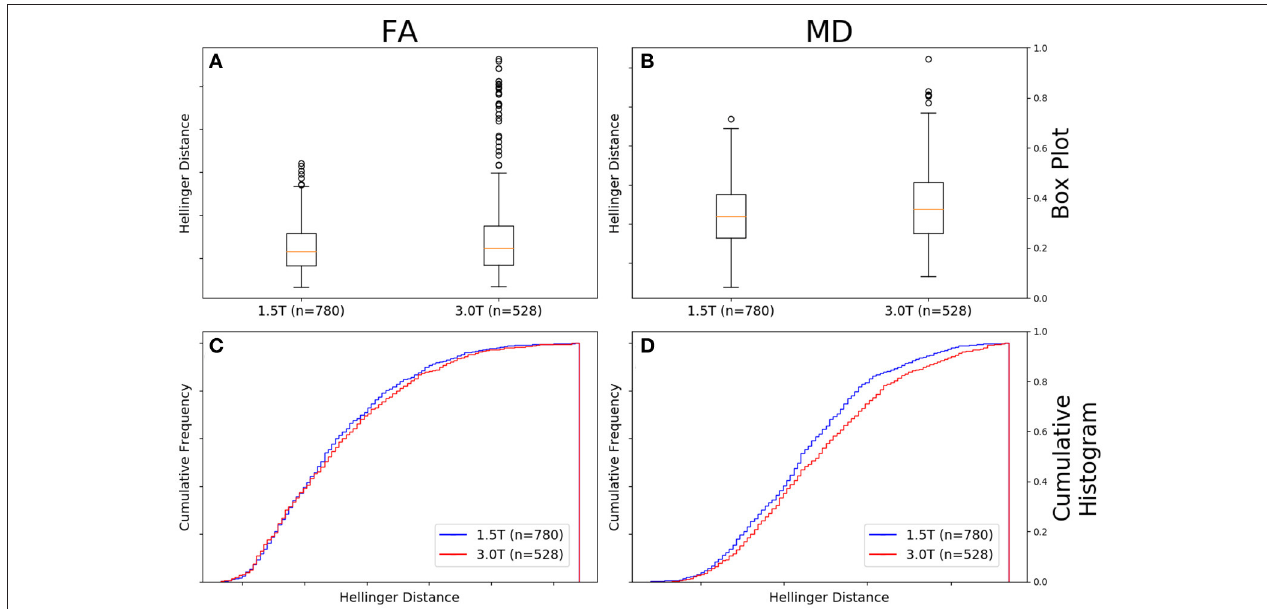
FIGURE 9 | FA (A) and MD (B) map box-and-whisker plot for GE 6 gradient directions ( n = 36,046 comparisons) vs. GE 25 gradient directions [( n = 153,735 comparisons) for b = 1,000 s/mm 2 and 1.5T. Cumulative histograms for these data are shown for FA (C) and MD (D) ].